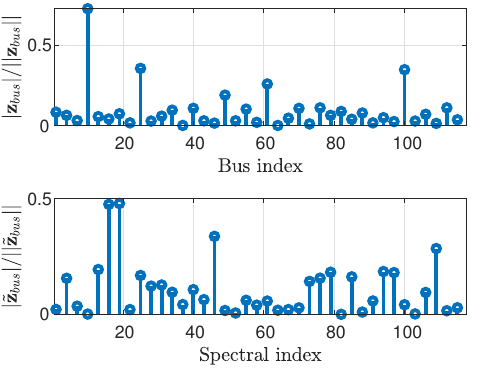
Figure 3. The active power measurement vector ( top ) and its GFT ( bottom ) for the IEEE 118-bus system. Next, we validate experimentally that the states, θ , and the magnitudes, v , are sig- nificantly smoother than the power vector, z bus , by comparing their normalized Dirichlet energy for typical IEEE systems, as shown in Table 1. The values of the nodal admittance matrix, B = L , the voltages, and the power data are taken from [56]. It can be seen that the phases and magnitudes are much smoother than the power injection vectors. This result is reasonable, since the phase differences between connected buses are small under normal conditions and the magnitudes are approximately constant [31], while the power may be very different, since each generator/load injects different amounts of power into the